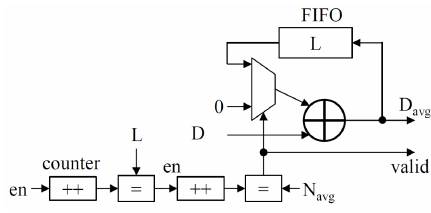
Figure 6. Implementation of the averaging